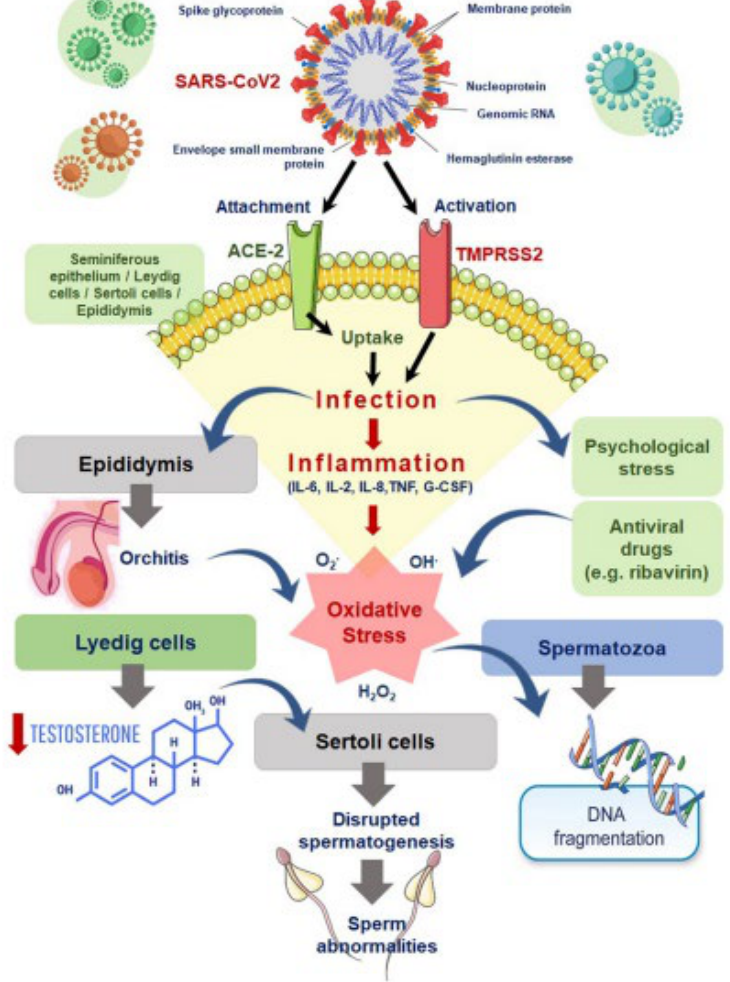
Figure 1. The Potential Mechanism of SARS-CoV-2 Affecting the Reproductive Function